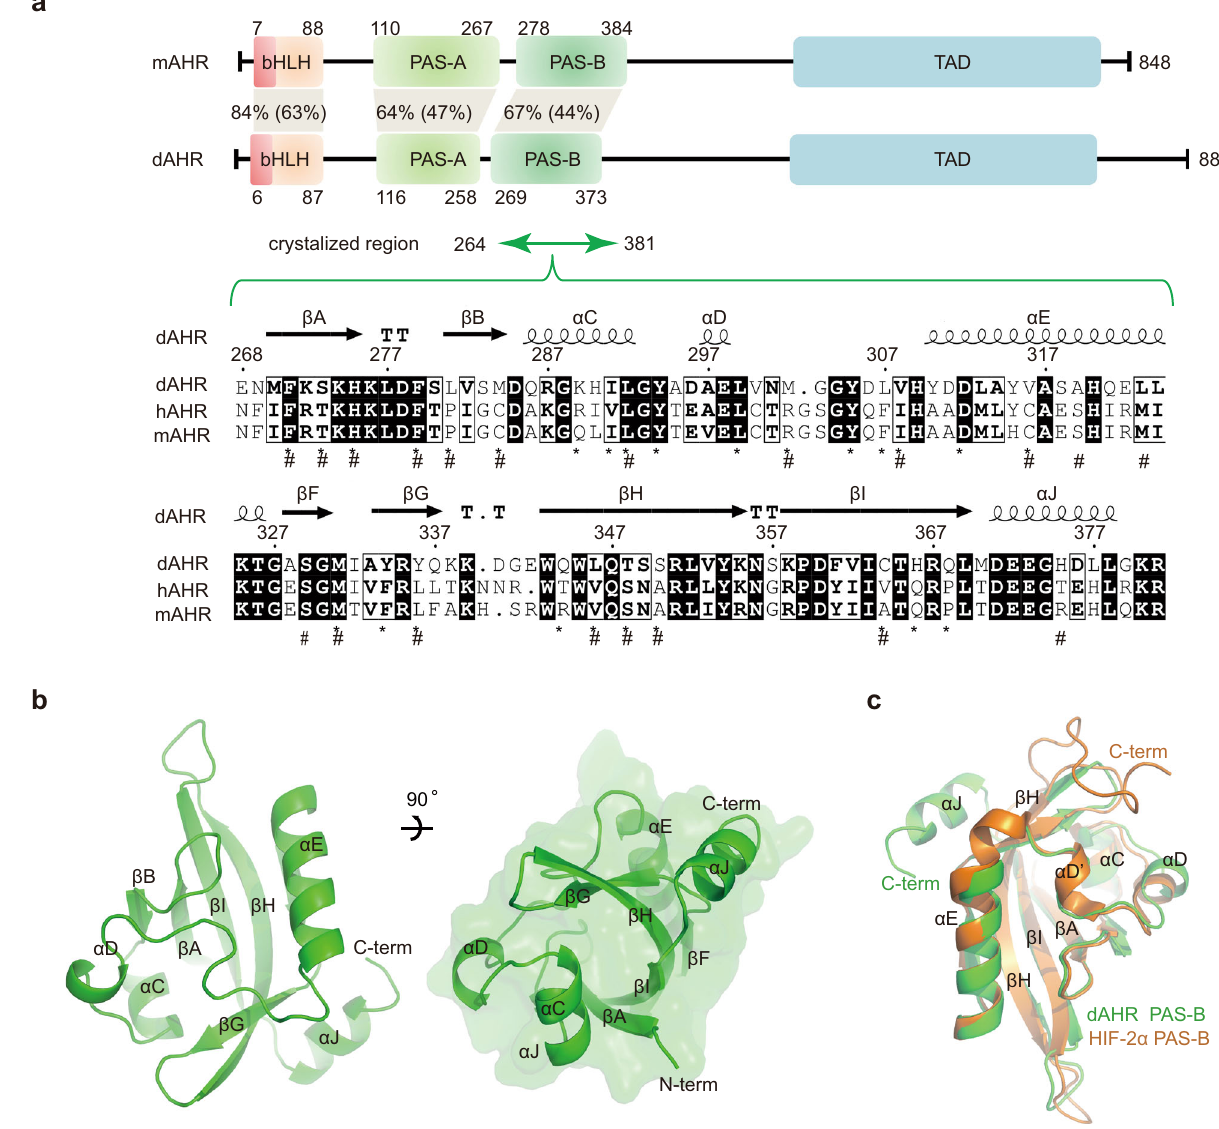
Fig. 1 | Overall structure of dAHR PAS-B. a Domain arrangements of mAHR and dAHR. Amino acid similarities and identities (in parentheses) between the corre- sponding domains of mAHR and dAHR are indicated. A multiple sequence align- ment fi le of the crystallized sequence is provided. The residues lining the interior cavities of dAHR and mAHR are indicated by ‘ # ’ and ‘ * ’ , respectively. Sequences